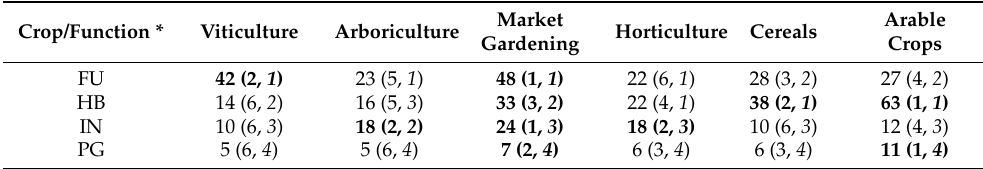
Market Arable Horticulture Cereals Gardening Crops